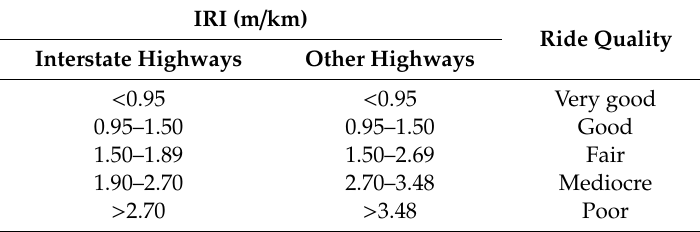
Table 4. Evaluation of Road Pavement According to IRI.